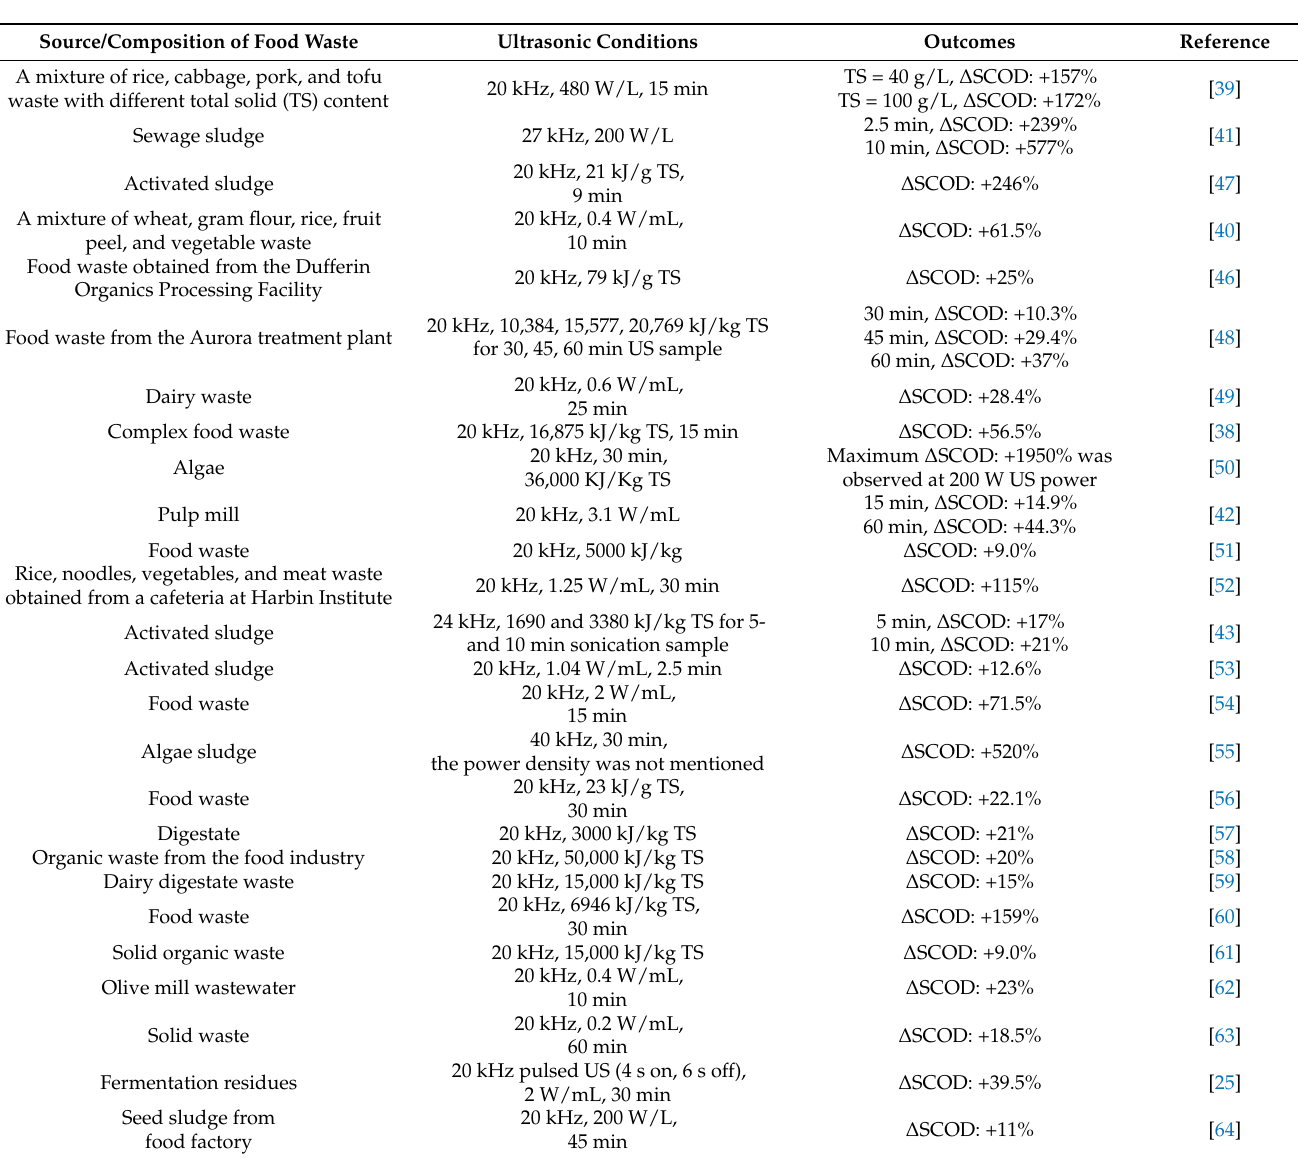
Table 1. The influence of ultrasound on SCOD